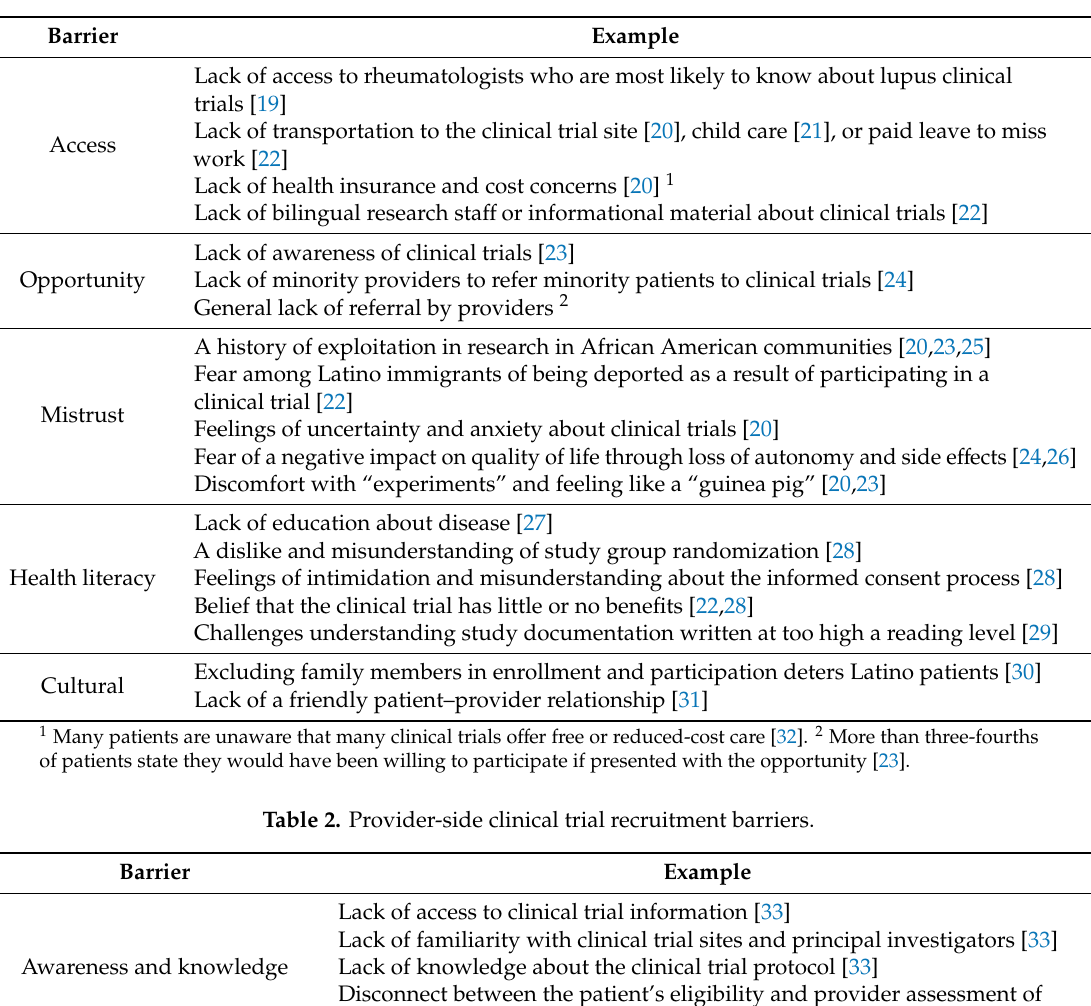
Table 1. Patient-side clinical trial participation barriers.